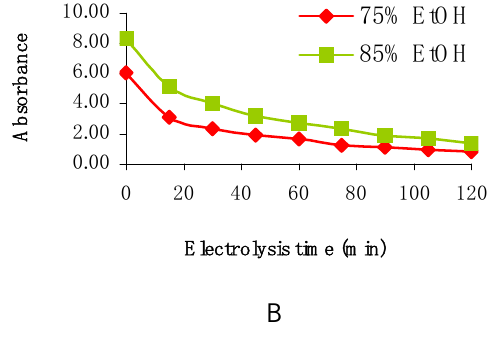
concentration of extracted chlorophyll solution; A: with aluminium as electrodes, B: with iron as electrodes; ♦ , 75% ethanol; ■ , 85% ethanol